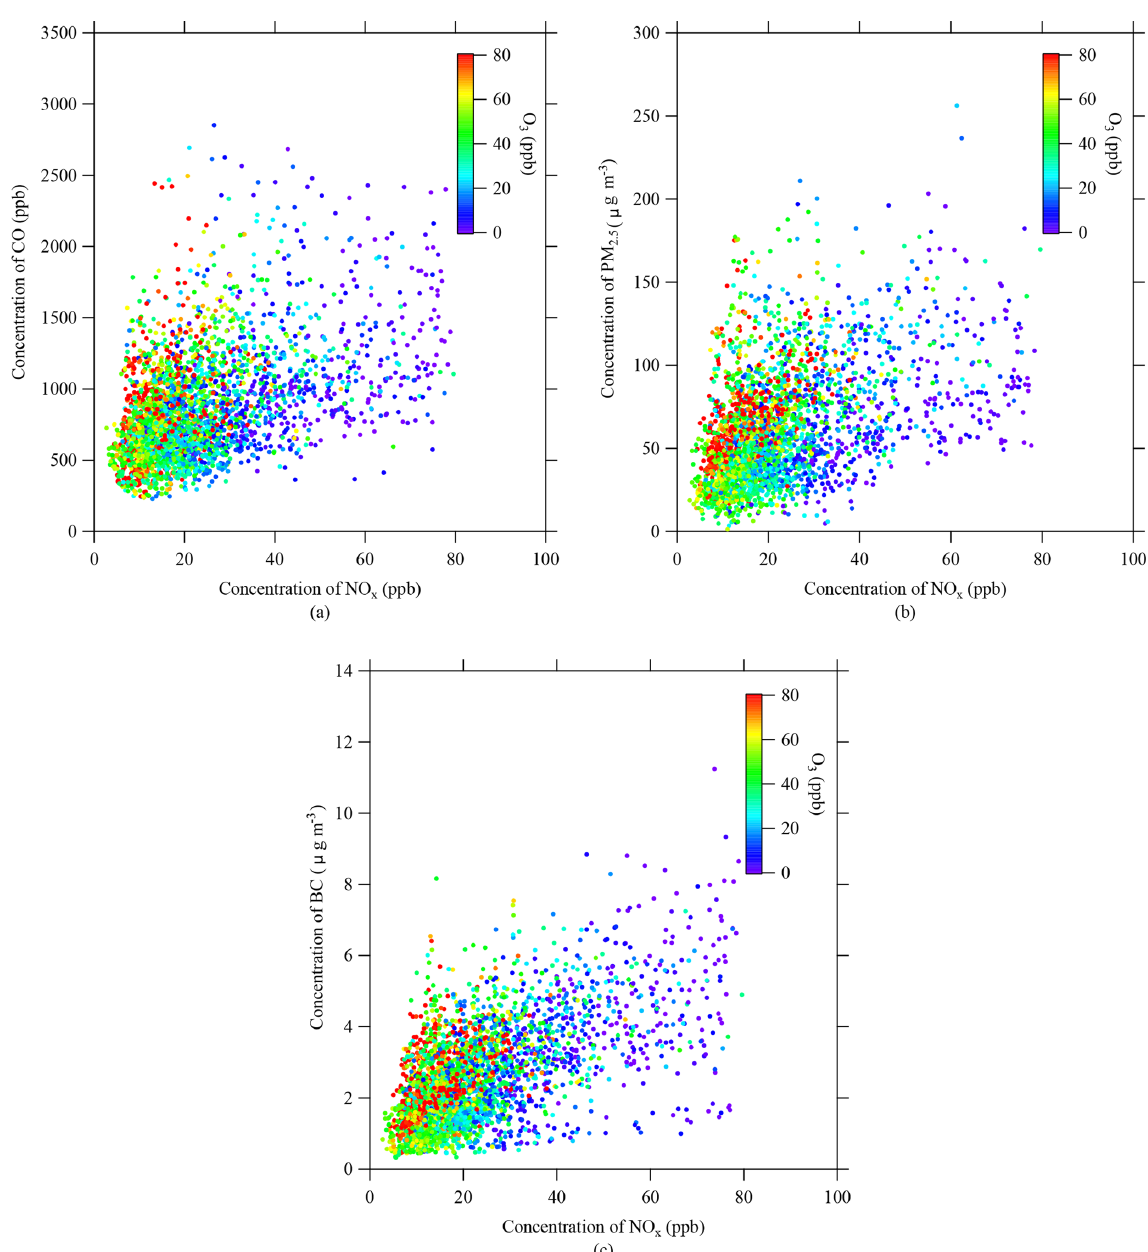
Figure 10. Scatter plots of (a) CO–NO x , (b) PM 2 . 5 –NO x , and (c) BC–NO x color-coded with O 3 .